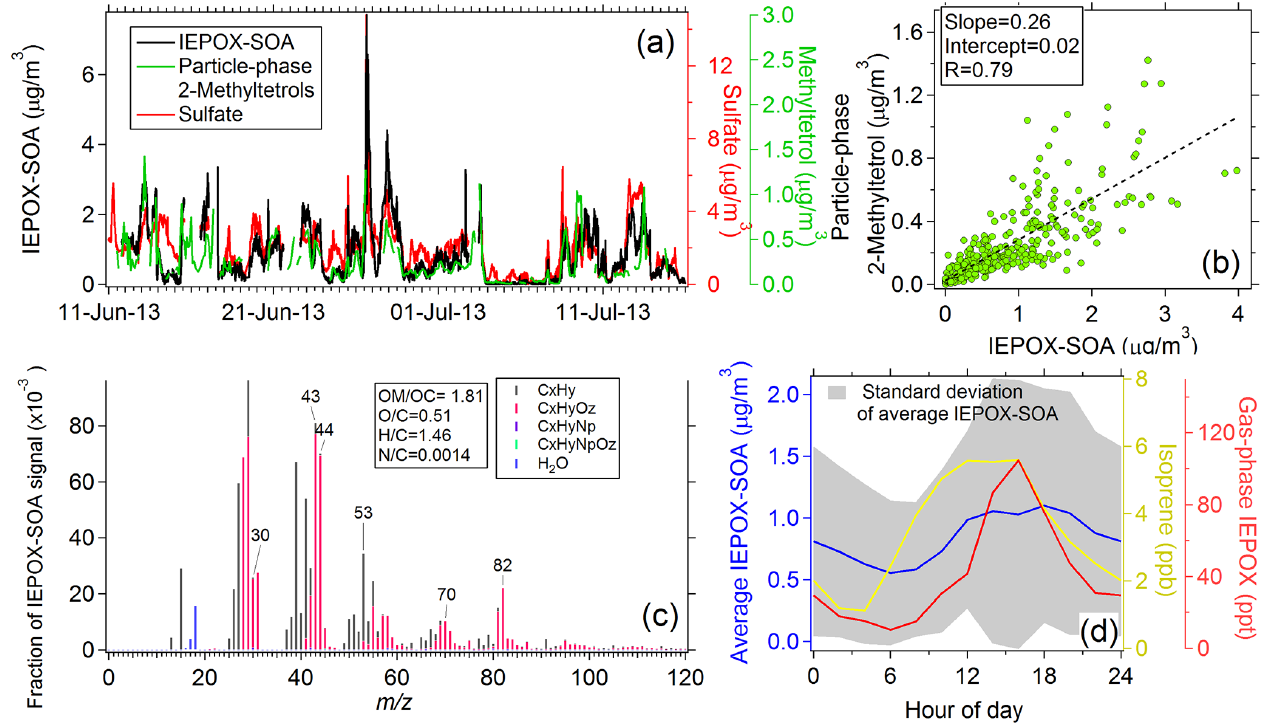
Figure 2. Results from the SOAS campaign in a SE US forested site. (a) Time series of IEPOX-SOA PMF , sulfate, and particle-phase 2- methylterols (a key IEPOX uptake product) from on-line GC/MS; (b) Scatter plot between particle-phase 2-methylterols and IEPOX-SOA. (c) Mass spectrum of IEPOX-SOA; (d) Diurnal cycle of IEPOX-SOA, isoprene, and gas-phase IEPOX (the latter measured by CF 3 O −